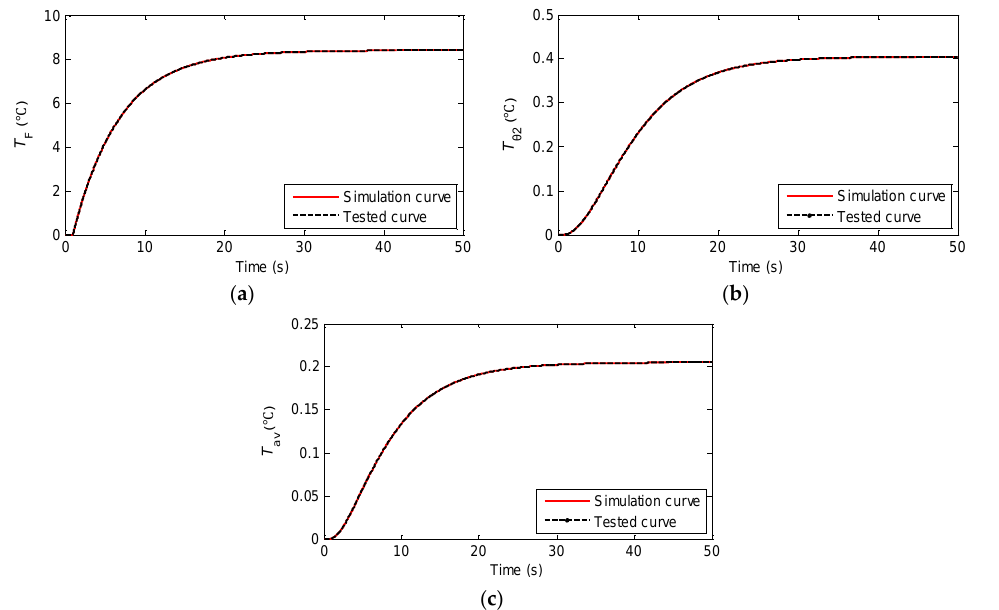
Figure 9. Core fuel and coolant temperature module simulation comparison. ( a ) Change of T F ; ( b ) change of T θ 2 ; and ( c ) change of T av .